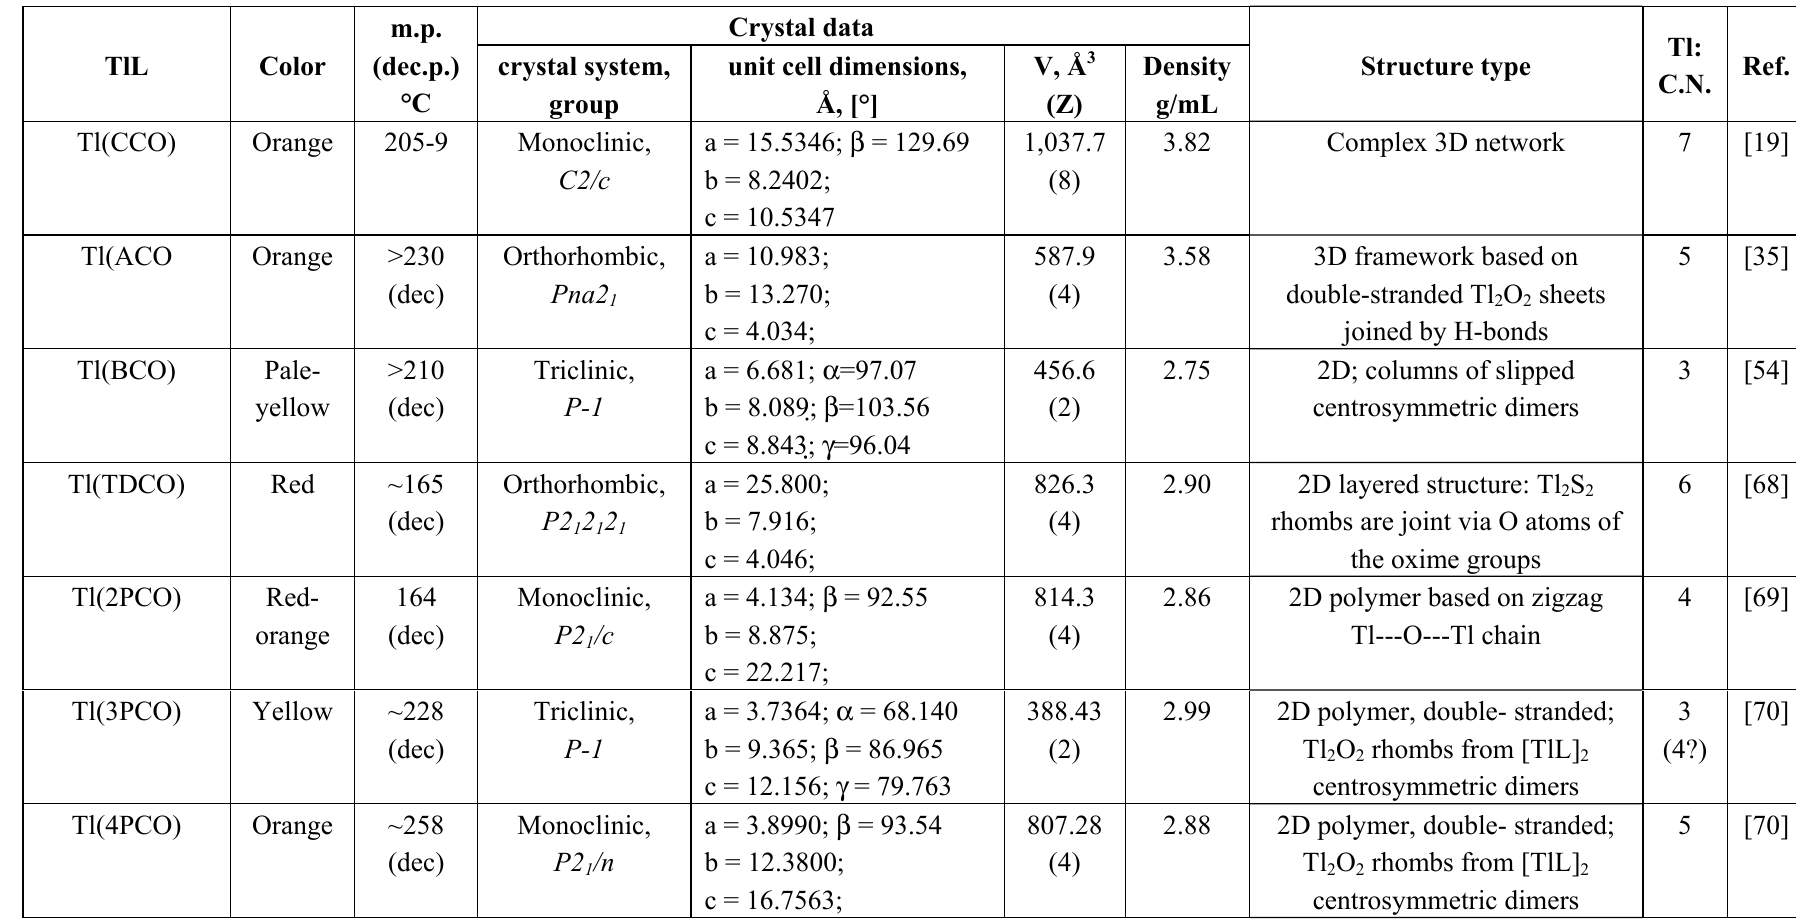
Table 2. Some chemical-physical parameters and crystal structures data for known up to date polymeric Tl(I)